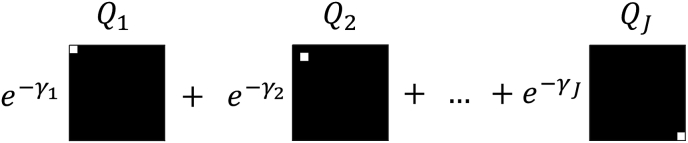
The form of the precision components. Each component Qj has a single non-zero entry at element (j,j), which is set to 16. These are scaled by the corresponding log scaling parameters γj. See Equation (10) for further details.